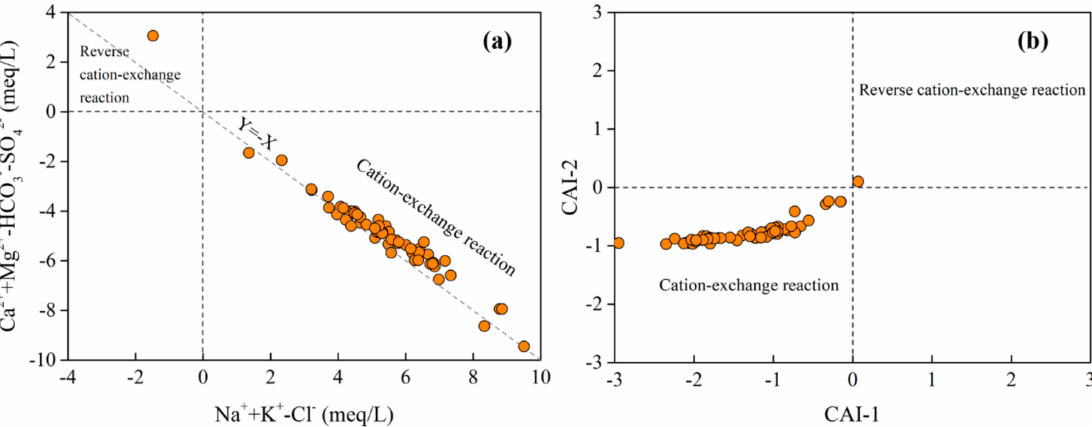
Figure 13. Scatterplotsof( a )Na + + K + − Cl − versusCa 2 + + Mg 2 + − HCO 3 − − SO 42 − ,and( b )chloro − alkaline indices CAI–1 versus CAI–2.